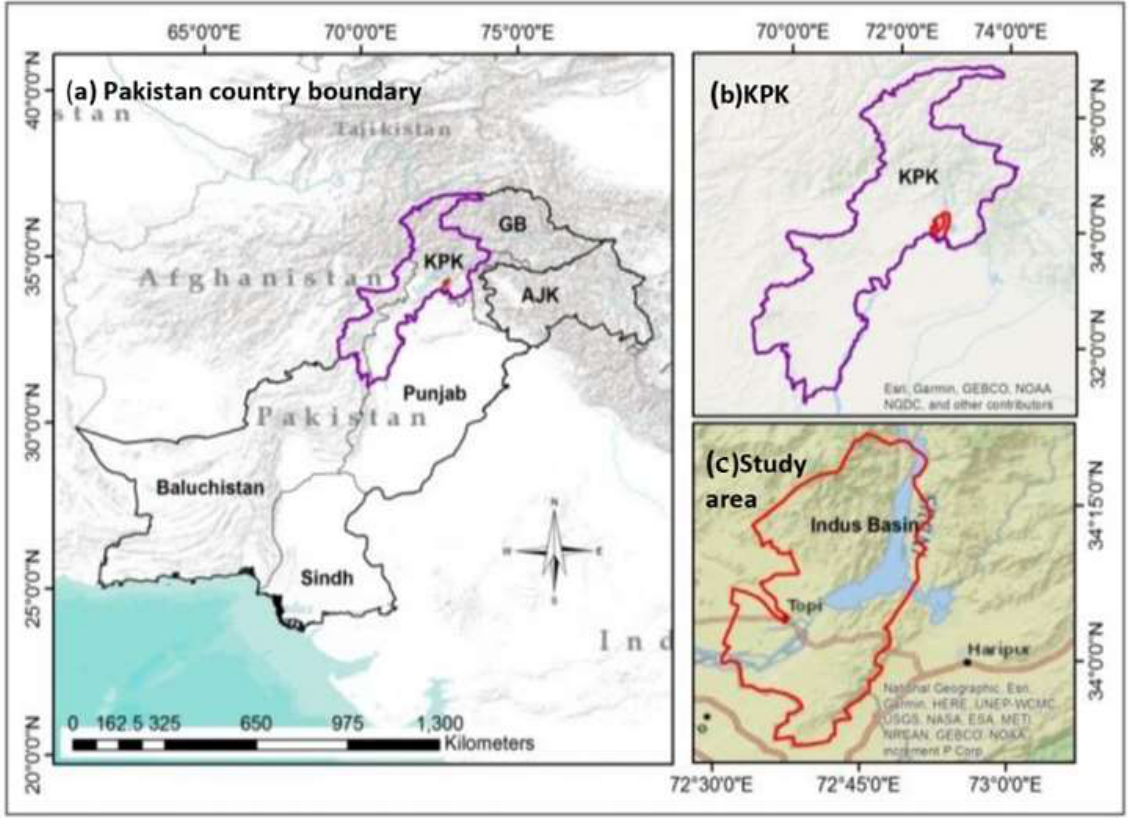
Figure 1. Study area map (Lower Mountainous Indus Basin area Terbella, Pakistan) ( a ) Country, ( b ) Province, and ( c ) Study area Terbella.